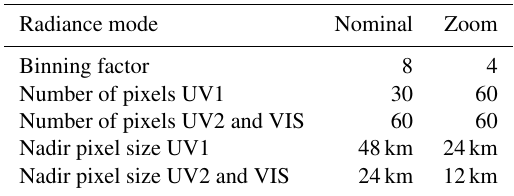
Table 2. Spatial sampling properties in nominal and zoom measure- ment